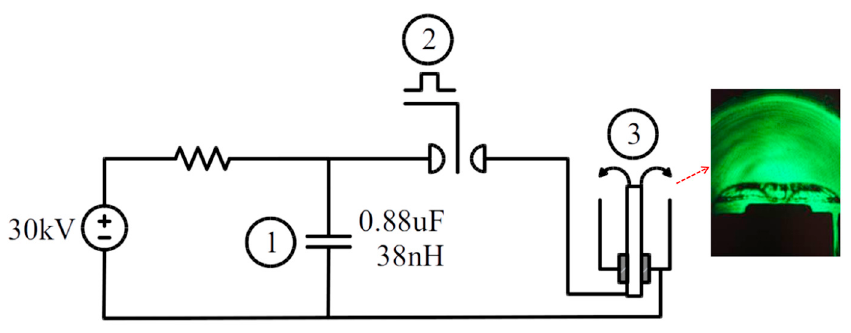
Figure 2. Schematic of plasma focus PF-400J. Operation: ( 1 ) the capacitor is charged up to 27 kV; ( 2 ) a signal triggers the spark-gap and ( 3 ) the current flows through the coaxial electrodes.